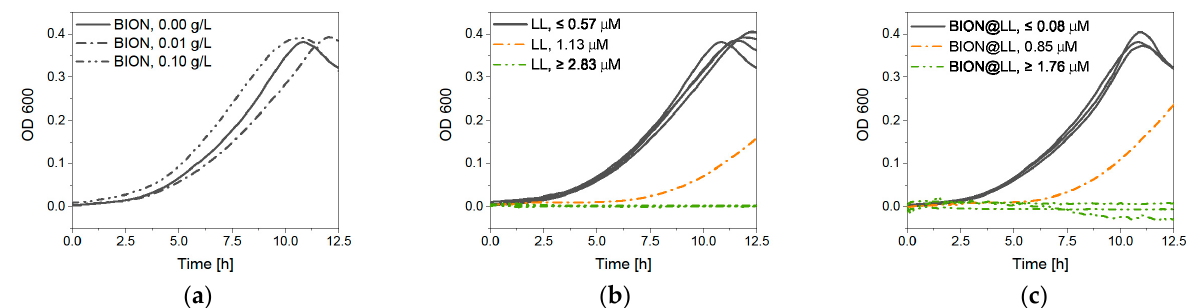
Figure 9. OD 600 measurements of E. coli (BL21 (RH) 4 GFP expressing) in M9 medium under different ( a ) BION concentrations, ( b ) LL concentrations, and ( c ) amounts of the MNP@LL complex. The concentration in the diagram of MNP@LL describes to the LL concentration.